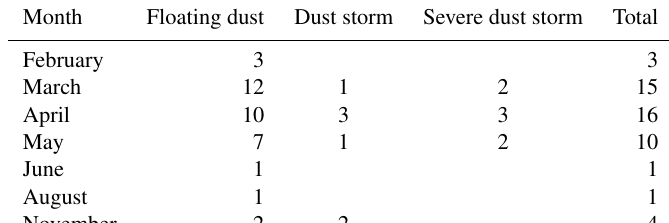
Table 3. Monthly summary of dust days in China during 2011–2015.